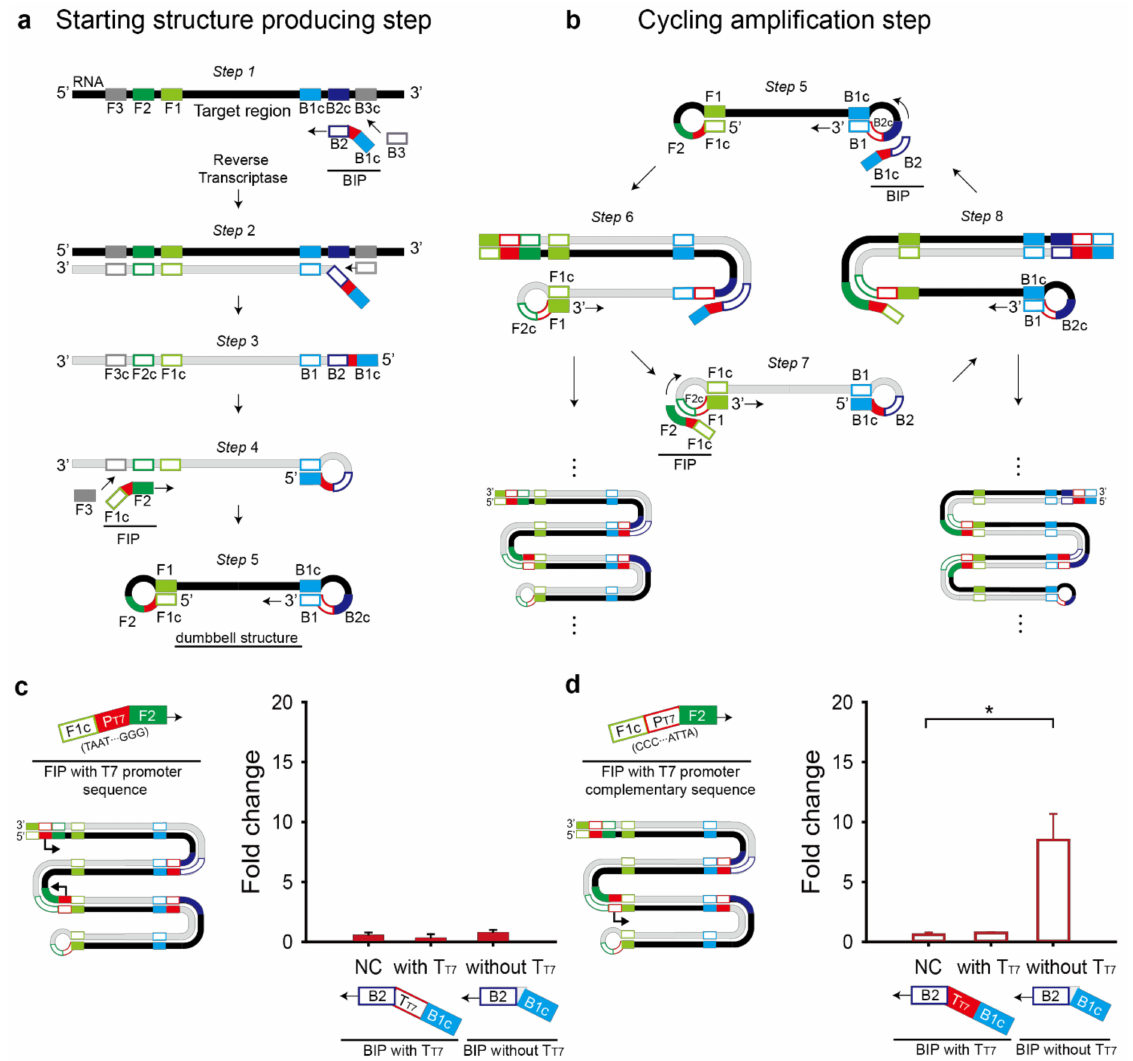
Figure 3. Schematic illustration of the modified RT-LAMP reaction consists of a starting-structure-producing step ( a ) and a cycling amplification step ( b ). ( c ) T7 promoter (P T7 ) and complementary T7 terminator (T T7 ) were inserted into inner primers, FIP and BIP, respectively. With different combinations of the modified primers, RT-LAMP and the subsequent toehold reaction in the paper-based cell-free system were performed. Fold change was calculated as the absorbance value with trigger RNA divided by that without the trigger RNA. ( d ) Complementary T7 promoter (P T7 ) and T7 terminator (T T7 ) were inserted into inner primers, FIP and BIP, respectively. Sensor M6 and its target RNA (20 pM) were used and the RT-LAMP was done without loop primers. For the fold change calculation, the absorbance value was obtained with 60-min RT-LAMP and 60-min toehold reaction. For the negative control (NC), the RT-LAMP reaction product with no target RNA was used. Two-tailed student’s test; * p < 0.05; Error bars represent ± s.d., n =